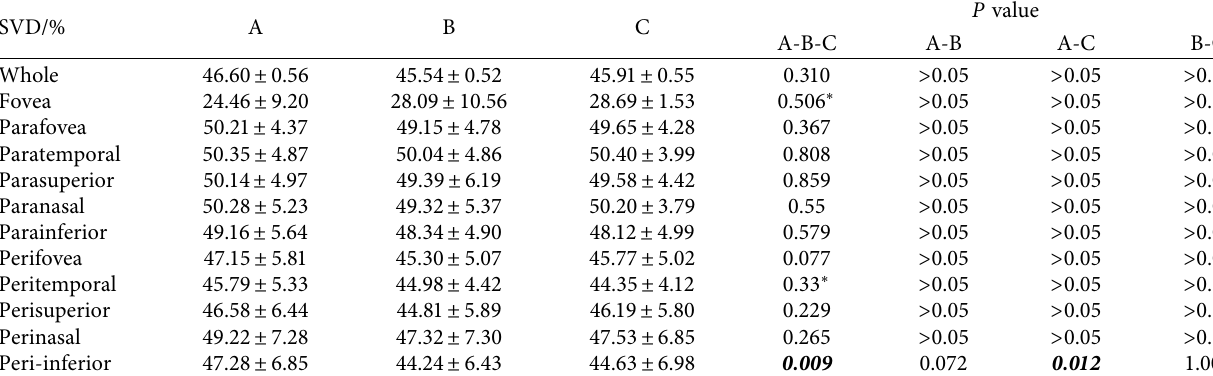
Table 2: SVD in the three diagnostic groups.